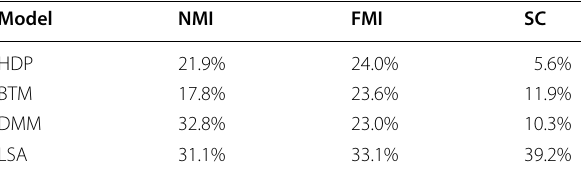
Table 4 Performance improvement of PCIF-LDA and non-LDA models